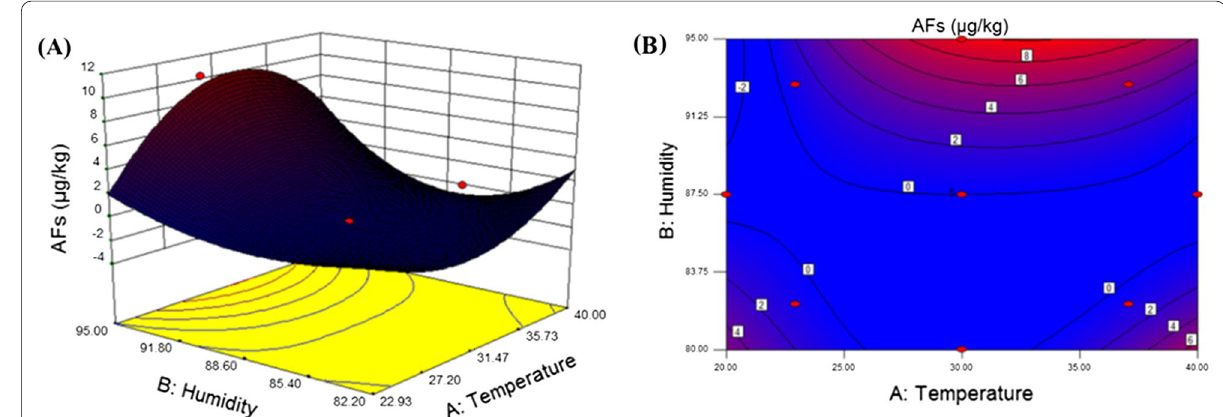
Fig. 5 A Response surface plots, and B contours of various factors for A.